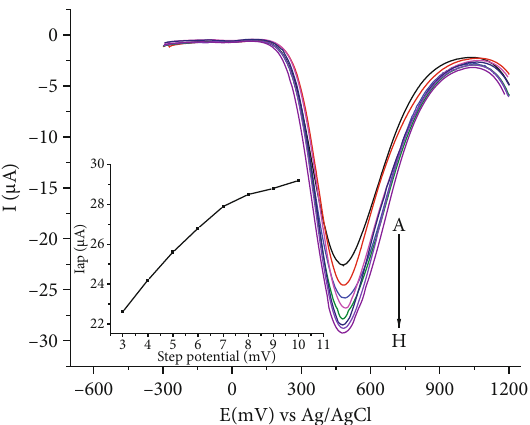
Figure 6: SWVs of AQMCPE in pH 4 PBS containing 2 mM AA at di ff erent step potentials (a – h: 3.0, 4.0, 5.0, 6.0, 7.0, 8.0, 9.0, and 10 mV, respectively). Inset: plot of anodic peak current vs. step potential.